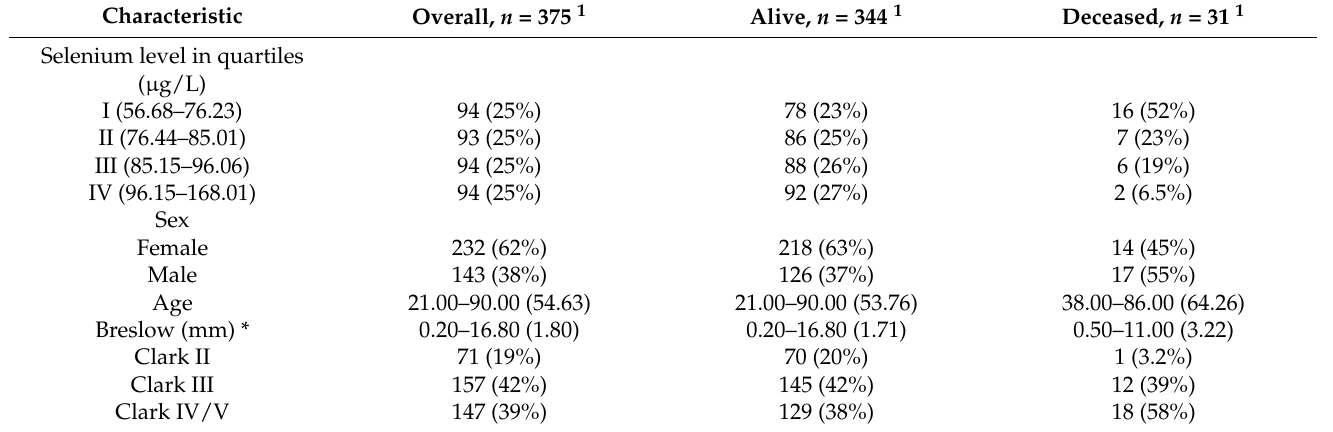
Table 1. Characteristics of the study group ( n = 375).